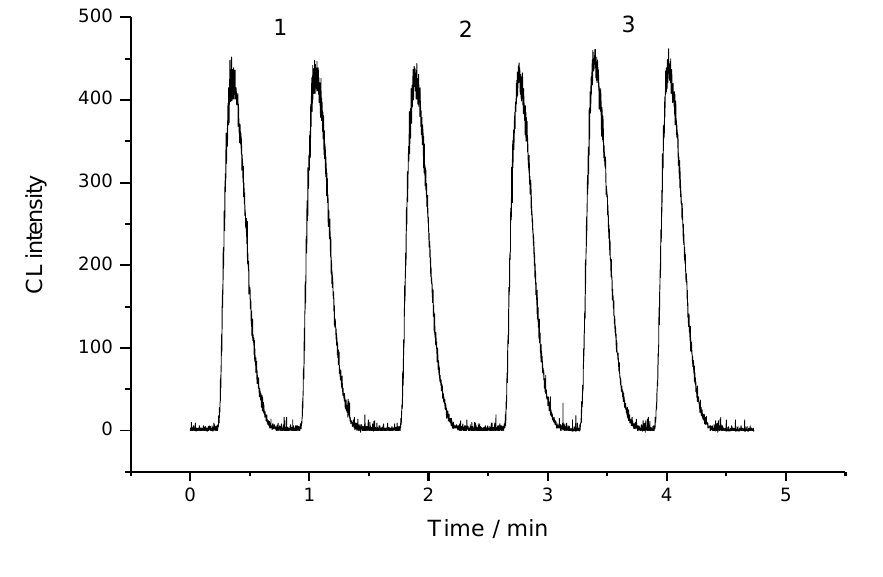
Figure 6. Reproducibility of the immunoaffinity reactor, 0.5 mM luminol + 4 mM H + 0.4 mM PIP at CEA concentration of 3